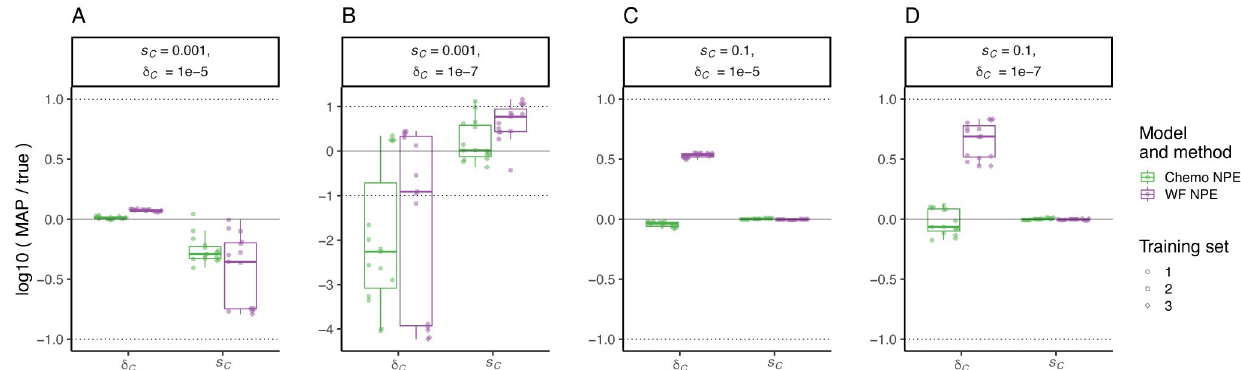
Fig 4. Inference with WF model from chemostat dynamics. The figure shows results of inference using NPE and either the WF or chemostat (Chemo) model on 5 simulated synthetic observations generated using the chemostat model for different combinations of fitness effect s Boxplots and markers show the log ratio of MAP estimate to true parameters for s C and δ C . Horizontal solid line represents a log ratio of zero, indicating an accurate MAP estimate; dotted lines indicate an order of magnitude difference between the MAP estimate and the true parameter. Data and code required to generate this figure can be found at https://doi.org/10.17605/OSF.IO/E9D5X. MAP, maximum a posteriori; NPE, Neural Posterior Estimation; WF, Wright–Fisher.